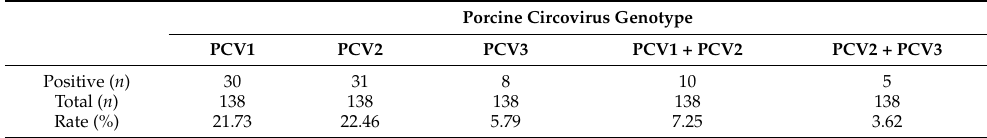
Table 4. Summary of PCVs detection in 138 wild boar samples.